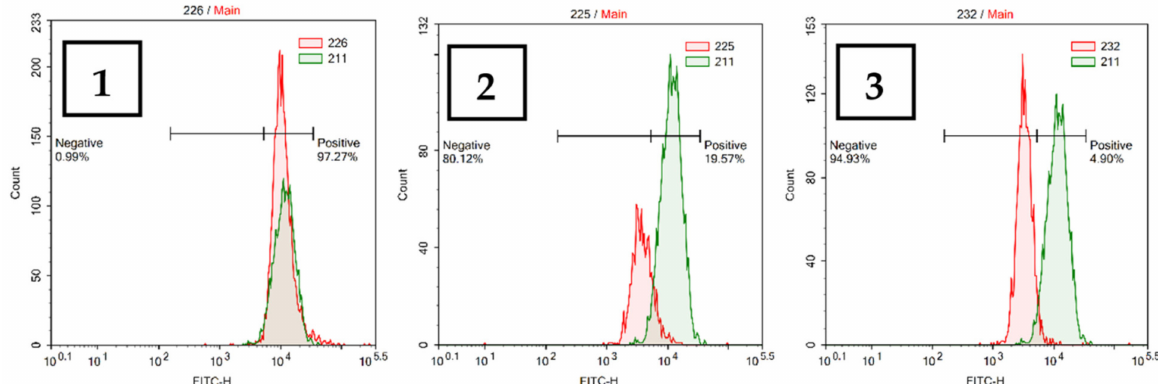
Figure 8. Loss of cytochrome c from the cells after incubation with trienoic acid 13c . ( 1 ) untreated Jurkat cells; ( 2 ) cells treated with staurosporine (0.1 µ M); ( 3 ) cells treated with compound 13c . The incubation time was 2